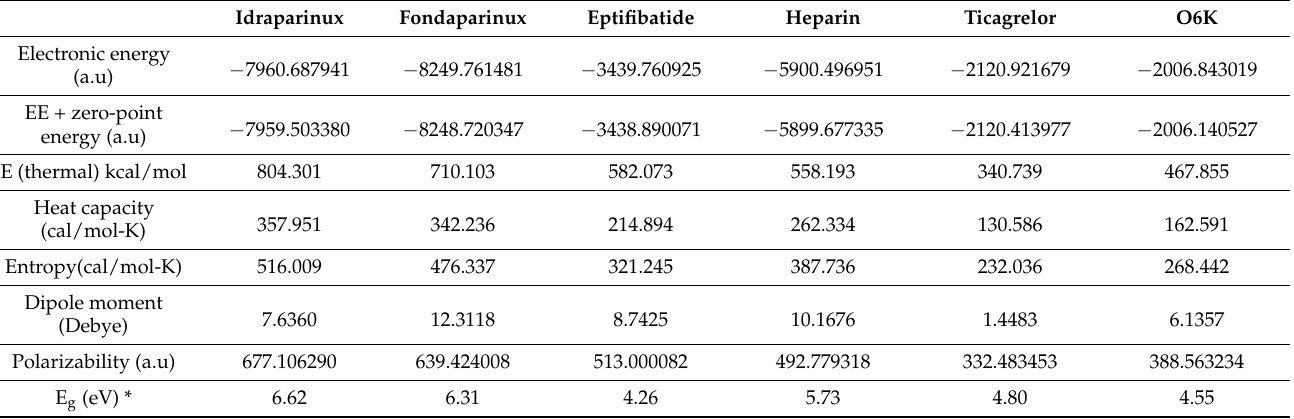
Table 3. Molecular parameters of the most promising compounds calculated at the B3LYP/6-311G* level of theory.